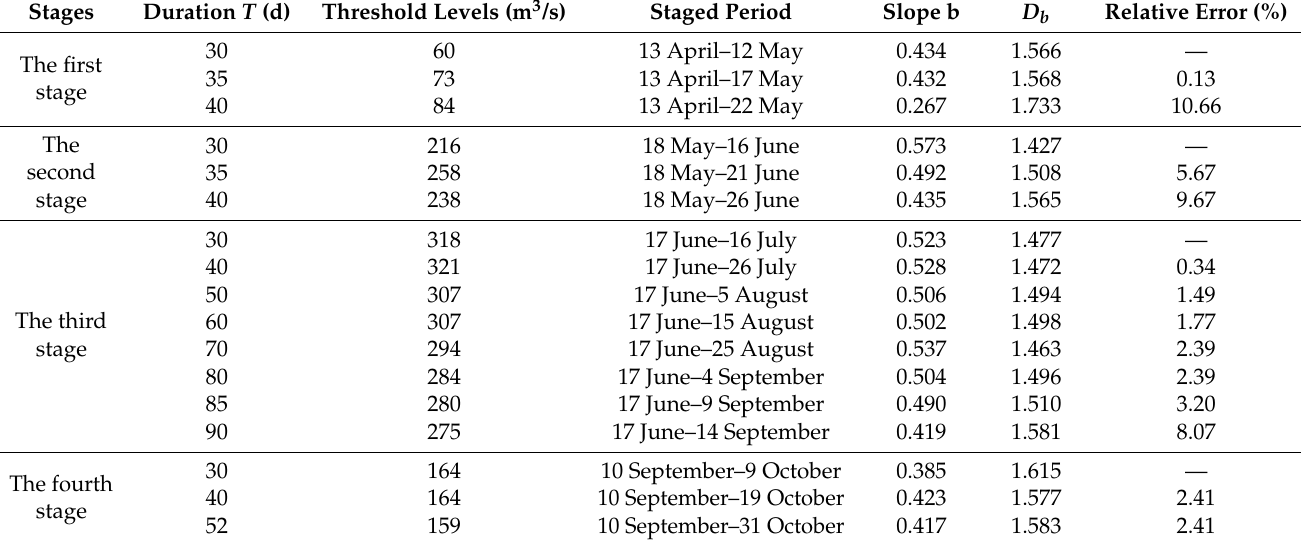
Table 5. Staging results of multi-year maximum daily runoff.